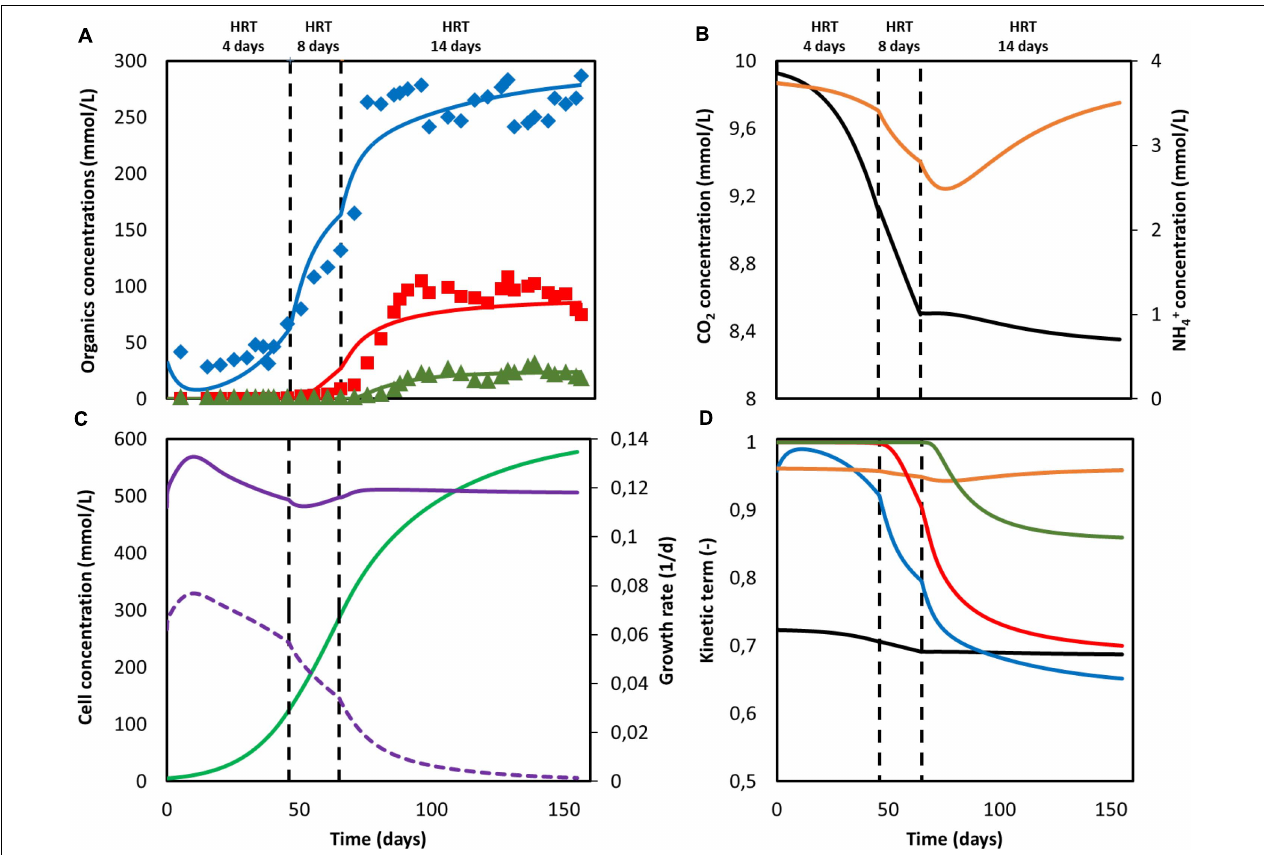
FIGURE 2 | Model fitting results (lines) and experimental data Jourdin et al. (2019) (markers). (A) Concentration of acetate (blue), butyrate (red) and caproate (green); (B) Substrate concentration of CO 2 (black) and NH 4 + (orange); (C) Cell concentration (light green), maximum growth rate (purple), and growth rate (purple dashed line); (D) Kinetic uptake terms of CO 2 (black) and NH 4 + (orange), and kinetic product inhibition terms of acetate (blue), butyrate (red), and caproate (dark green). The vertical dashed lines represent the time when the hydraulic retention time was